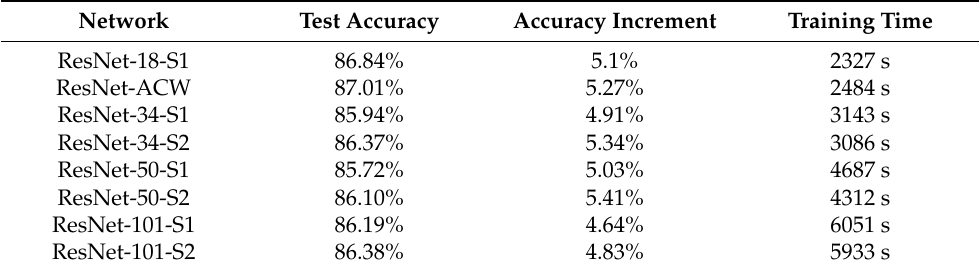
Table 8. Test results of S1 and S2 structures combined with ResNet of different depths. Network